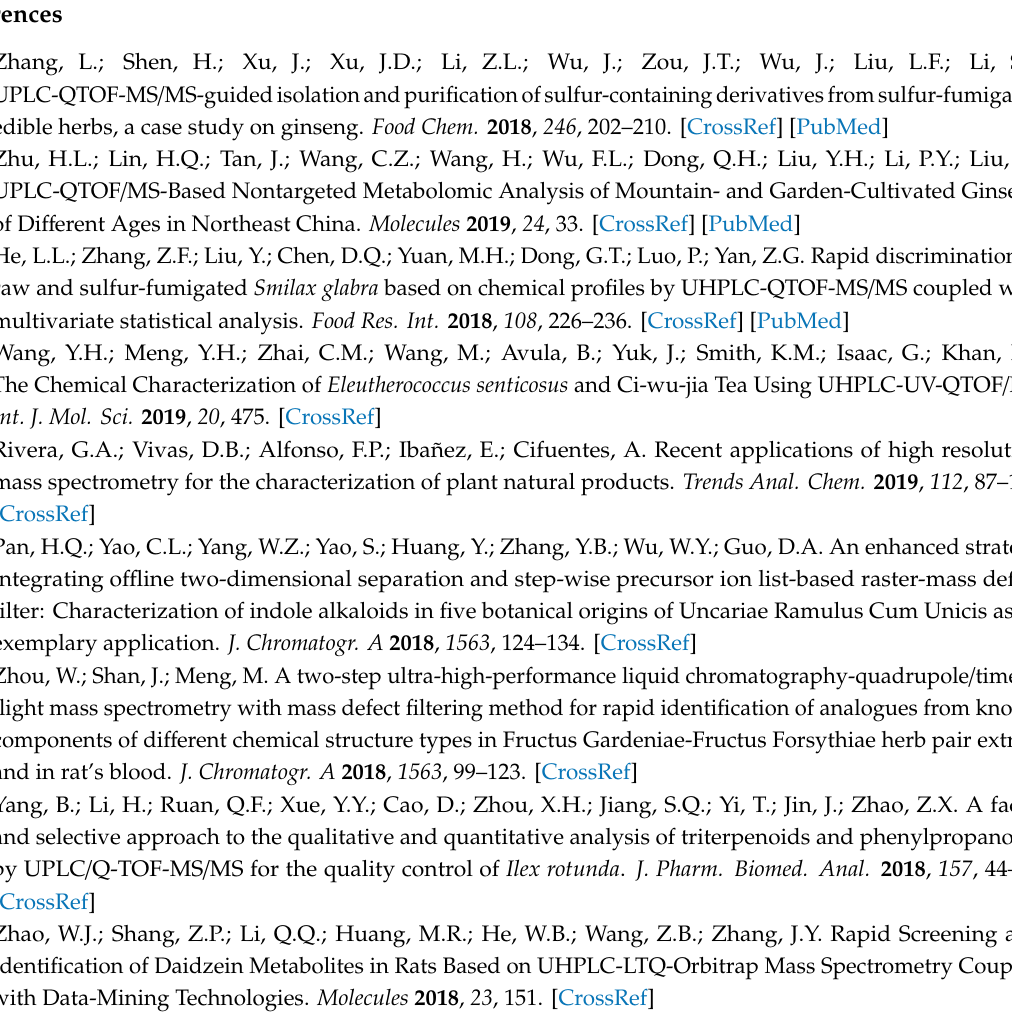
Figure S1: Chromatograms of B. aromatica extract with di ff erent extract method, Figure S2: Chromatograms of B. aromatica extract with di ff erent extract solvent, Figure S3: Chromatograms of B. aromatica extract with di ff erent extract